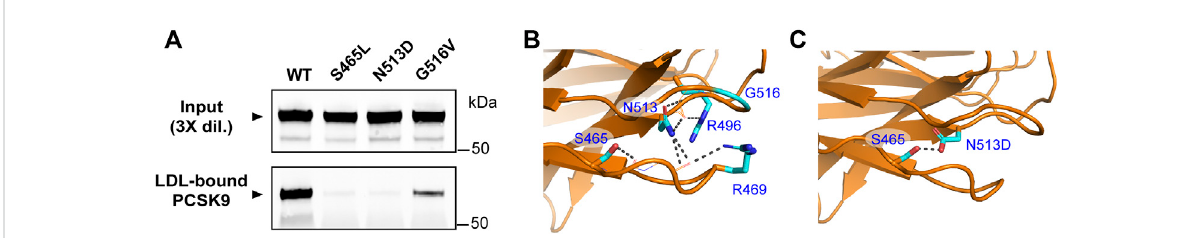
FIGURE 5 Multiple GOF mutations in the CM1 region of PCSK9 inhibit LDL binding. (A) Conditioned cell culture medium containing 1.0 μ g/ml wild-type PCSK9 (WT) or indicated mutants were incubated with LDL (0.5 mg/ml) prior to density gradient-ultracentrifugation and immunoprecipitation and Western blot analysis of LDL-containing fractions. Shown is a representative experiment ( n = 3) (B) Details of CM1 region showing close proximity of residues affected by FH mutations. The side-chains of S465, R469, R496, and N513 are positioned to form main-chain hydrogen bonds (grey broken lines). (C) Point mutationof Asn-513 to Asp was made in silico using theMutagenesis Wizard module of PyMOL (http://www.pymol.org) with rotamer (orientation) of highest frequency. In the model, Asp-513 is positioned to form a hydrogen bond with Ser-465 (grey broken